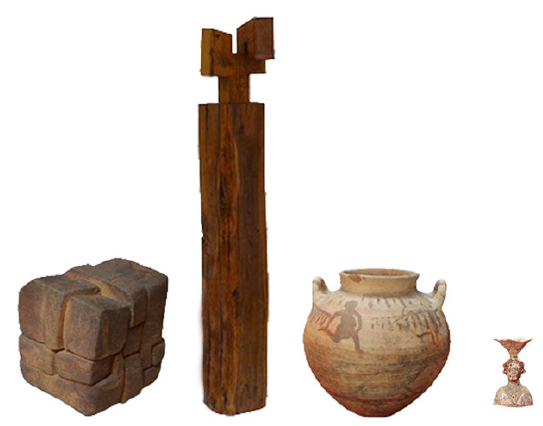
Figure 1. Sculpture and evidences surveyed at the Chillida-Leku Museum (left) and Archaeological Museum of Sarno (right)